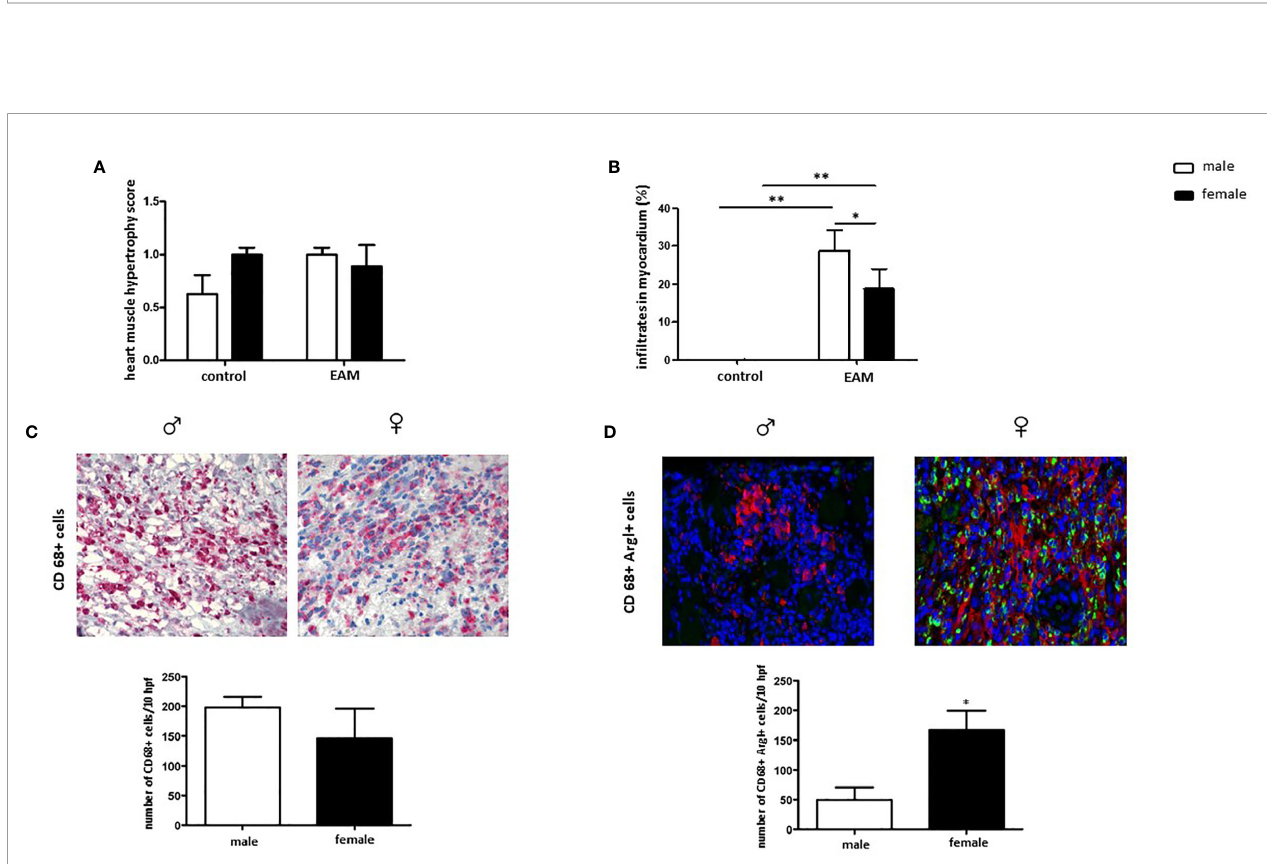
FIGURE 1 | Cardiac function in EAM rats. Cardiac function parameters from the left ventricle were measured by CMR. (A) Stroke volume (SV) (A) , ejection fraction (EF) (B) , and cardiac output (C) were assessed before immunization, 14, and21 daysafter immunization with cardiac myosin and CFAin male andfemale rats (n= 9-21). Data are shownas mean ± SEM. *p < 0.05.